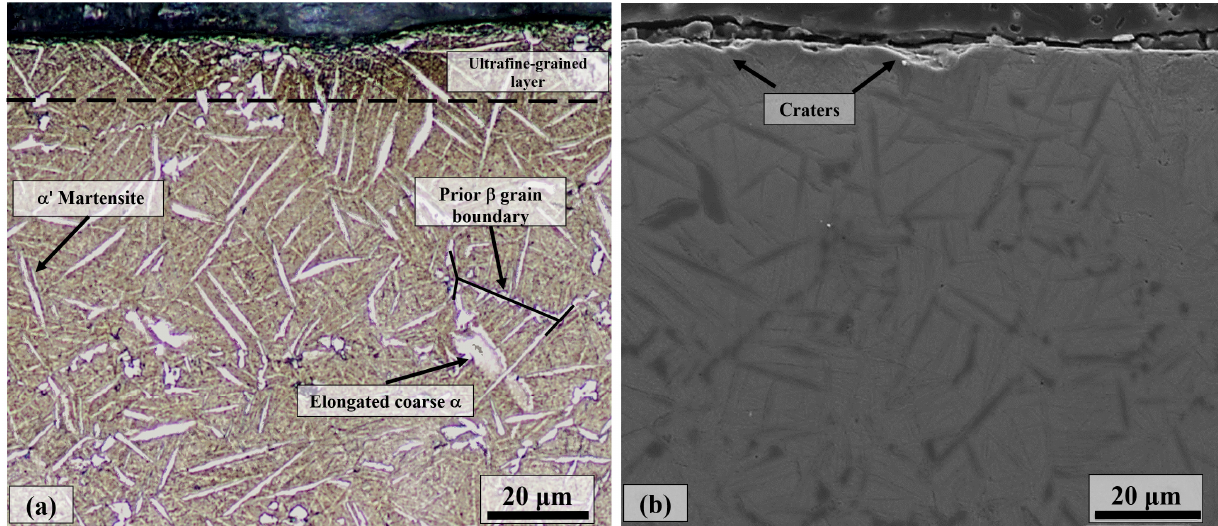
Figure 18. Cross-sectional optical ( a ) and SEM ( b ) images of shot-peened Cp-Ti sample, indicating deformation of surface and modification of subsurface microstructural features.